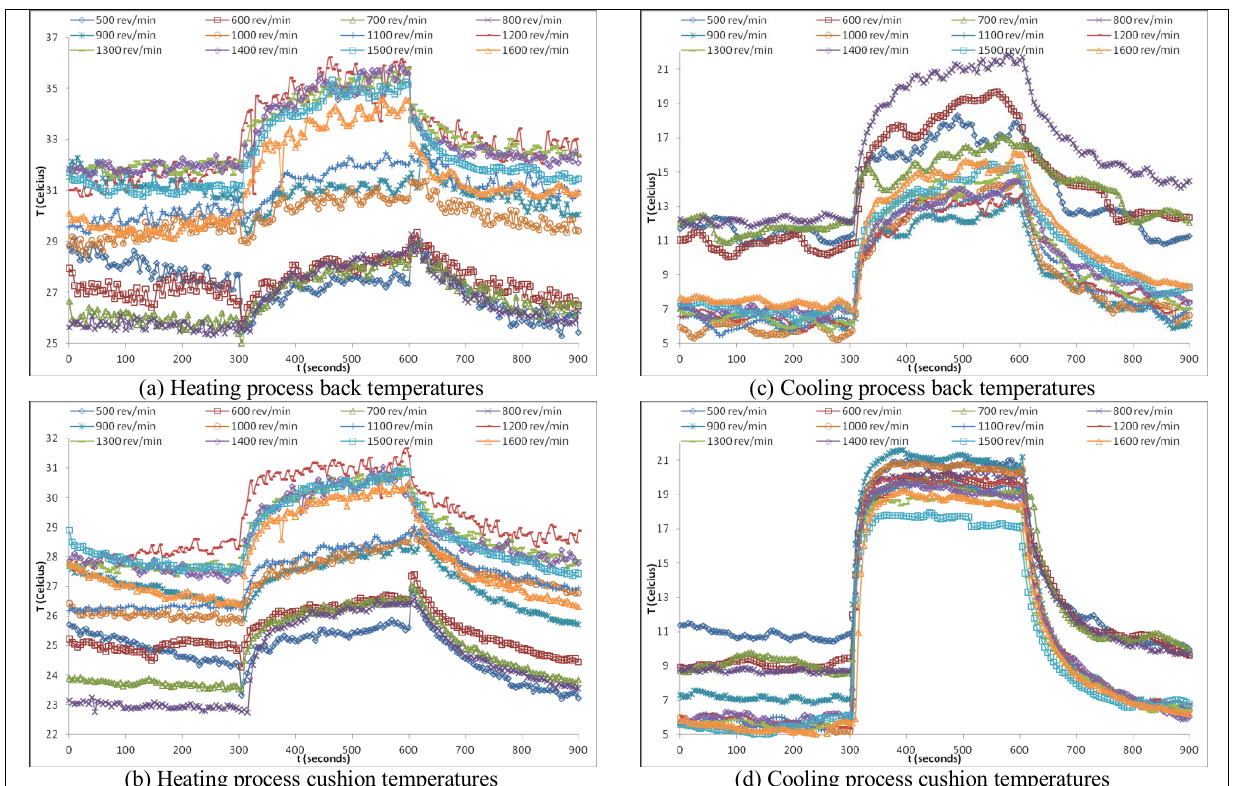
Fig. 7. Average cushion and back temperatures changing with time and compressor speeds for heating and cooling